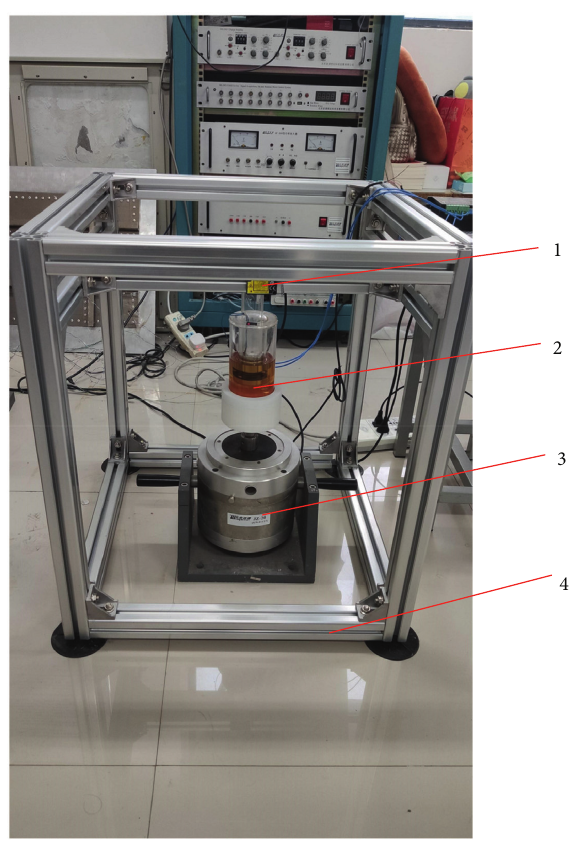
Figure 13: Hydraulic damper experimental device. 1, micro laser sensor; 2, hydraulic damper; 3, vibrator; 4,